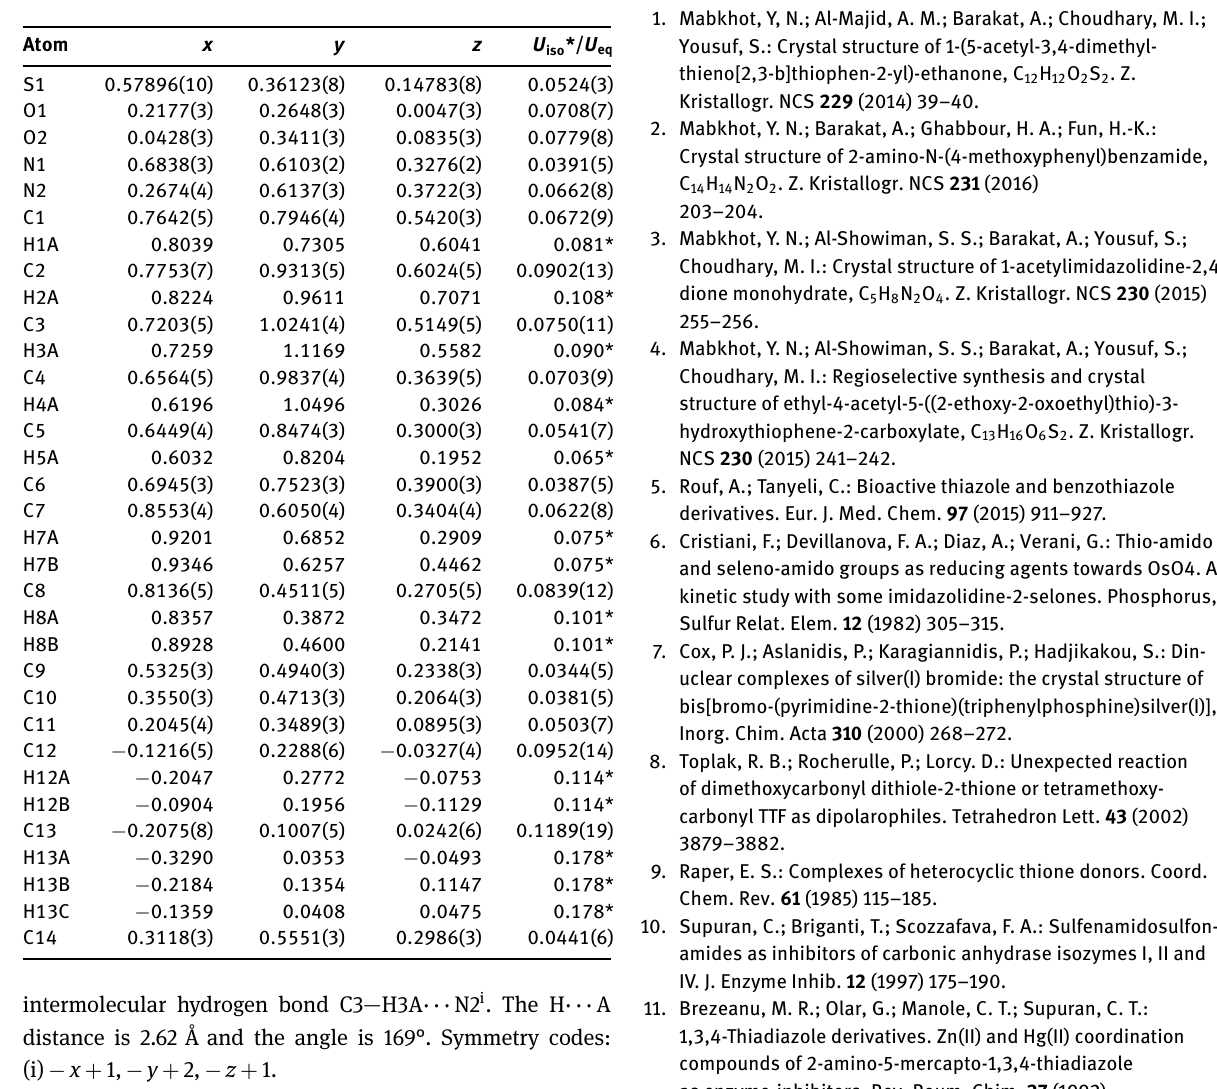
Table 2: Fractional atomic coordinates and isotropic or equivalent isotropic displacement parameters (Å 2